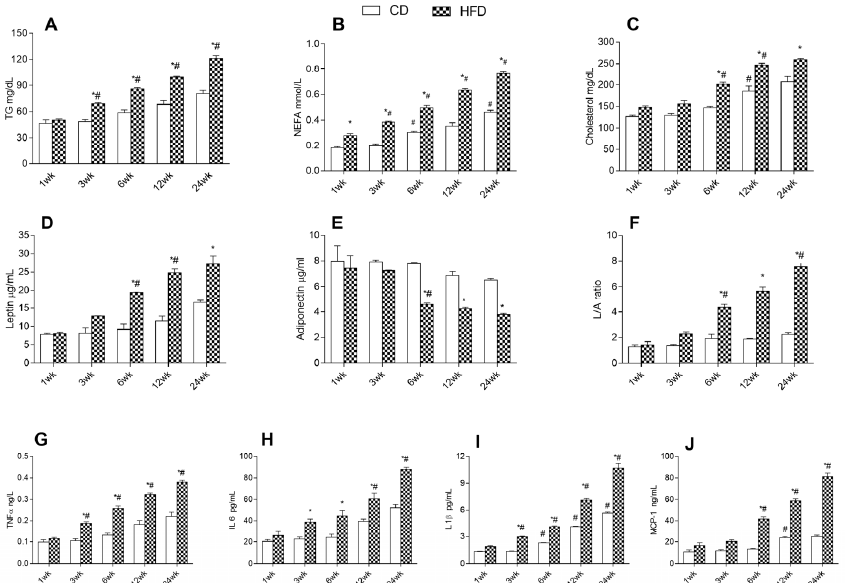
Figure 3. Effects of HFD and aging on serum parameters. All the parameters were measured throughout the experimental period (1–24 weeks): ( A ) triglycerides (TG); ( B ) not esterified fatty ac ‐ ids (NEFA); ( C ) cholesterol; ( D ) leptin; ( E ) adiponectin; ( F ) leptin/adiponectin (L/A) ratio; ( G ) tumor necrosis factors ‐α (TNF ‐α ); ( H ) interleukin ‐ 6 (IL ‐ 6); ( I ) interleukin ‐ 1 (IL ‐ 1); ( J ) monocyte chemoat ‐ tractant protein ‐ 1 (MCP ‐ 1) are shown. Data are indicated as means ± SEM from n = 6 animals/group. # Significantly different compared to previous time point, p < 0.05; * significantly different compared to CD group, p <